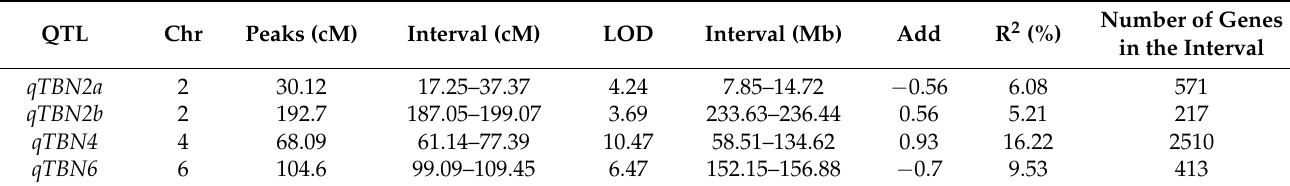
Table 2. List of colocated SNPs and the annotation of candidate genes.